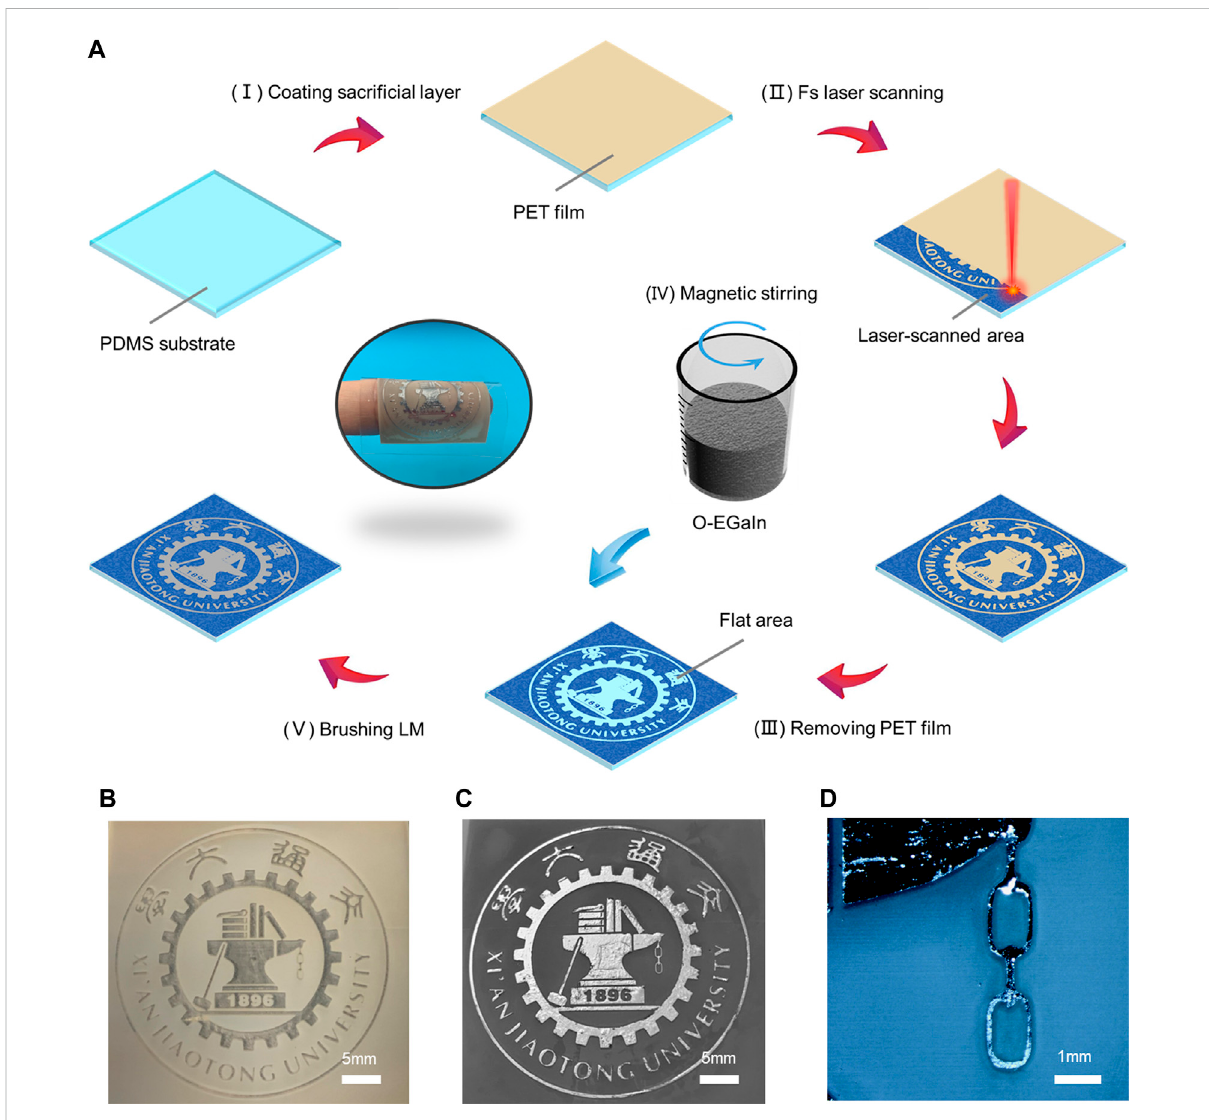
FIGURE 1 (A) Schematicdiagramofhigh-resolutionliquidmetalprintingmethodonPDMSsurface. (B) OpticalimageofalogoofXJTUonPDMSsubstrate after fs laser selective ablation. (C) Photograph of the liquid metal logo on the resultant surface with high resolution. (D) Photograph of the liquid metal logo on the resultant surface with higher magni fi